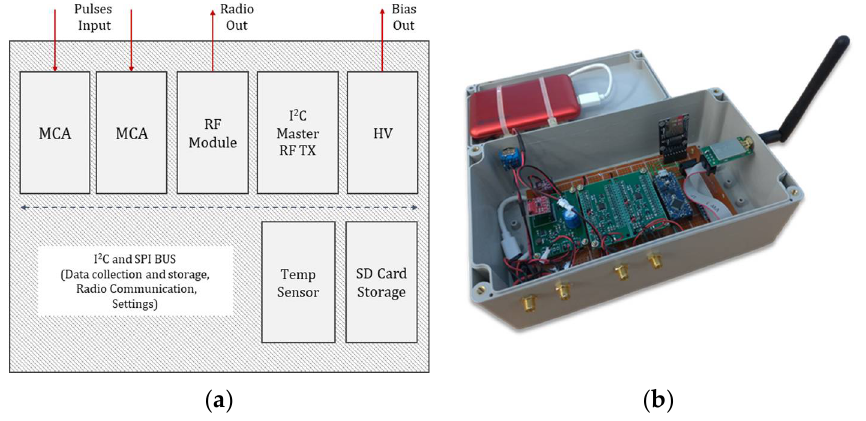
Figure 4. Architecture ( a ) and prototype ( b ) of the data acquisition and management system.